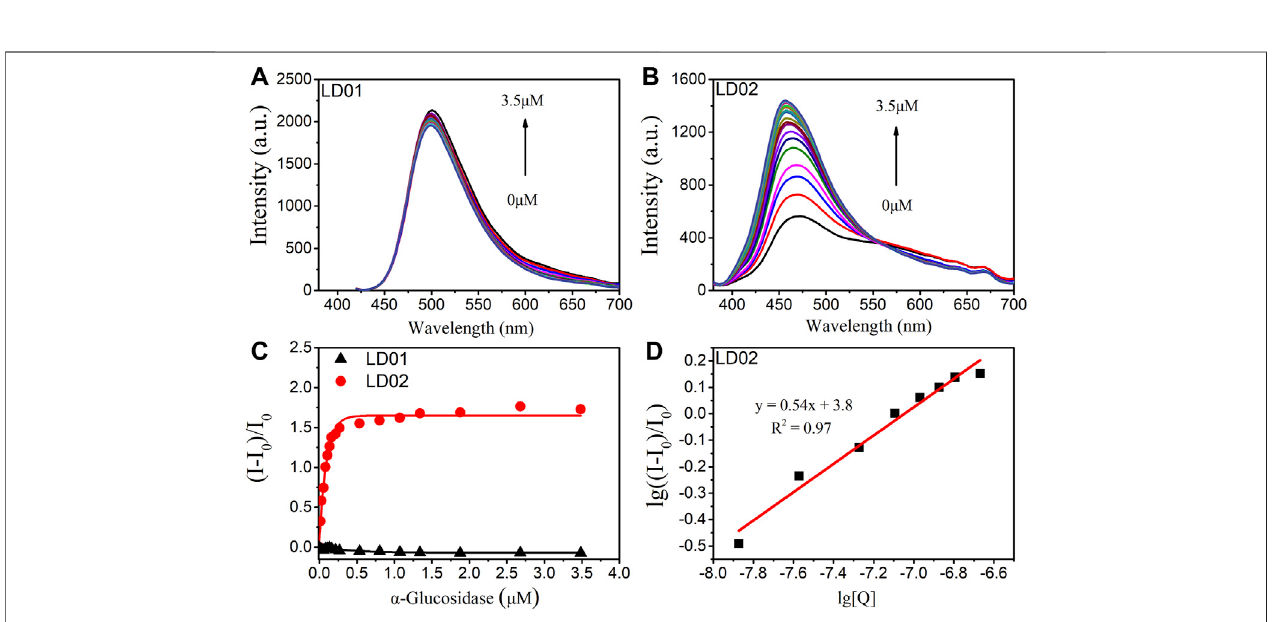
FIGURE 4 | Fluorescence spectra of LD01 (A) and LD02 (B) (10 μ M) in the presence of various concentrations of α -glucosidase (0 – 3.5 μ M) in PBS buffer. (C) Changesin(I-I 0 /I 0 )ofLD01( λ ex =410 nm, λ em =500 nm)andLD02( λ ex =365 nm, λ em =457 nm)onadditionof α -glucosidase. (D) Thelinearregressionlineoflg((I-I 0 )/I 0 ) to lg [Q], [Q] is the concentration of α -glucosidase